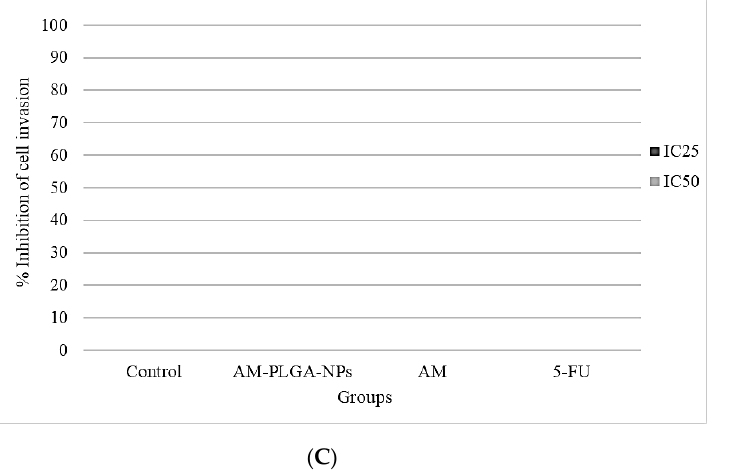
Figure 5. Inhibitory effects on the invasion of ( A ) HuCCT-1, ( B ) CL-6 and ( C ) OUMS-36T-1F cell lines following the exposure to the AM-PLGA-NPs, blank PLGA, free AM, and 5-FU for 72-h. Data presented as median (range) of the triplicate experiments.